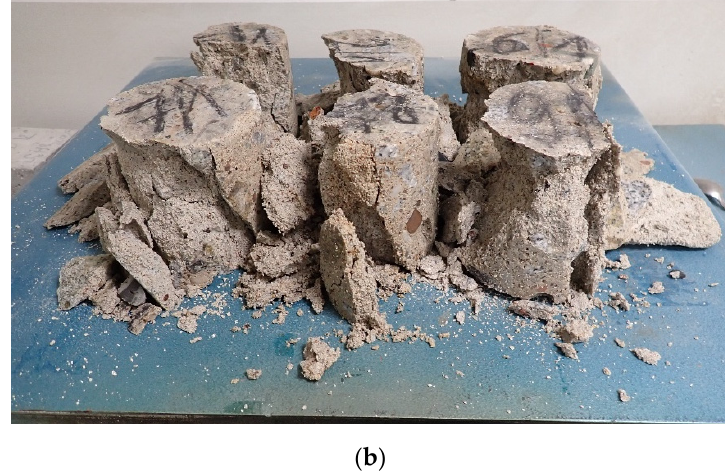
Figure 7. Frost resistance tests: ( a ) view of concrete specimens inside the freezing chamber after tests; ( b ) view of a form of failure concrete specimens.